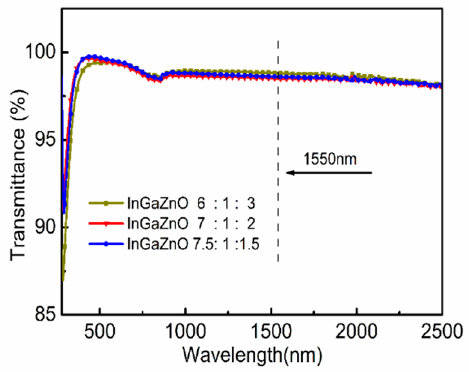
Figure 4. Transmission spectrum of nano film with di ff erent ratios.